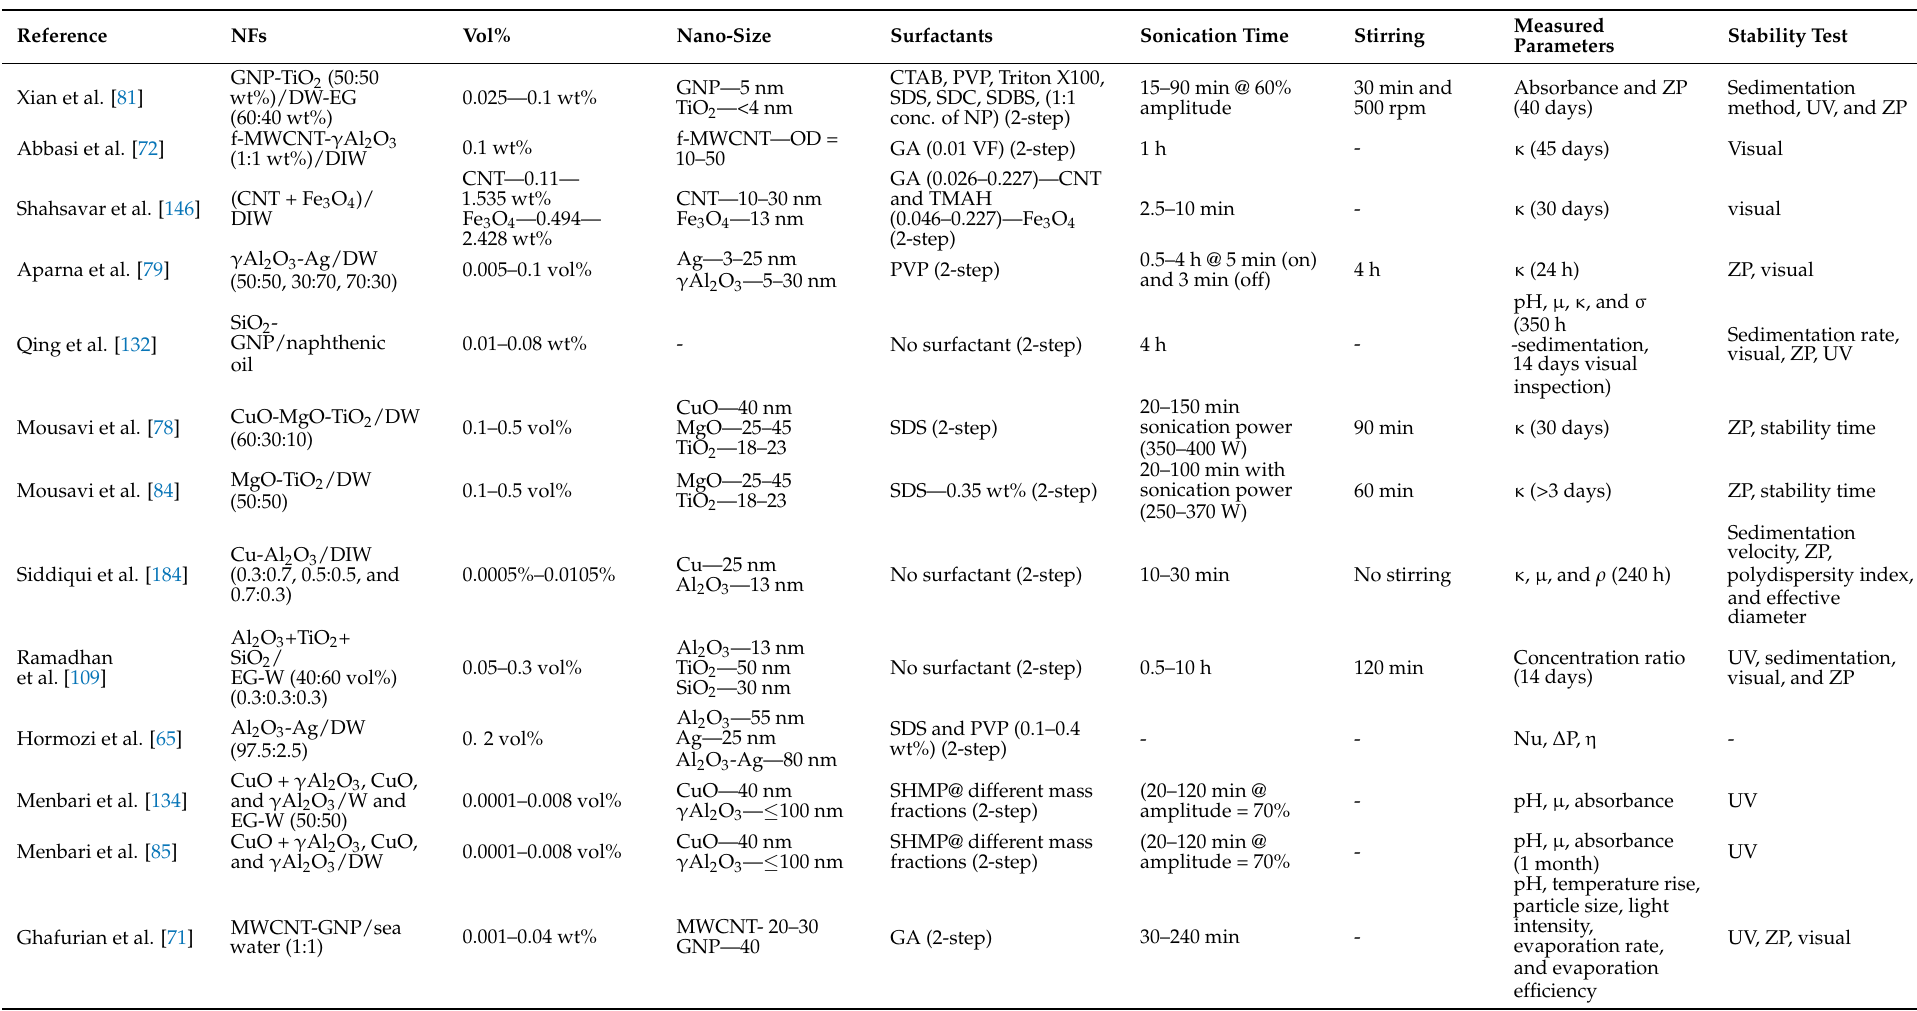
Table 6. Preparation characteristics, stability tests, properties, and performance of hybrid